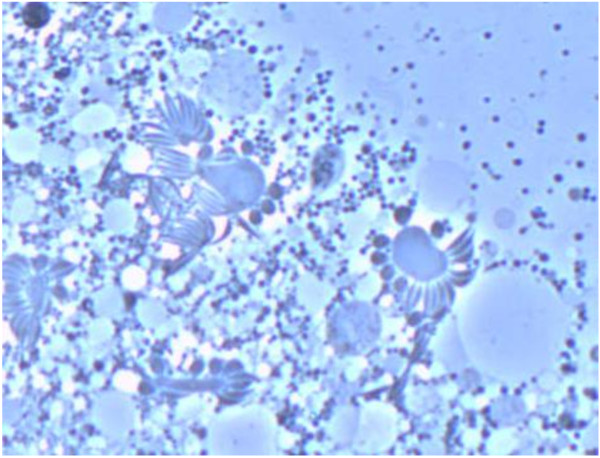
Sporozoite assembly around blastophores, from ruptured oocysts in the midgut. The sporozoites are all immature and at different stages of development (phase contrast, 400 × magnification).